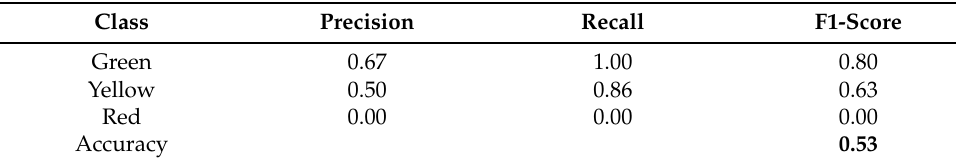
Table 10. Classification report for the SGD classifier.